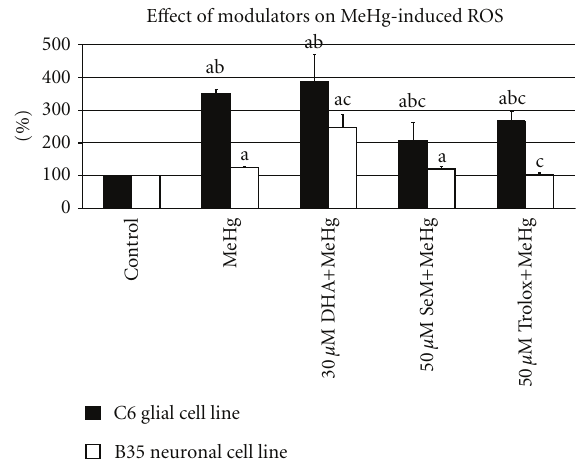
Figure 1: E ff ect of di ff erent modulators on MeHg-induced cellular ROS in C6-glial and B35-neuronal cell lines. Results are expressed as mean ± standard deviation ( n = 8 replicates for each cell type in two independent experiments). Superscript (a) indicates P < 0.05 for control versus each type of treatment; (b) indicates P < 0.05 for C6 versus B35 cell line for each type of treatment; (c) indicates MeHg versus DHA/SeM or Trolox+MeHg-treated group. Values represented the percentage of activity relative to control